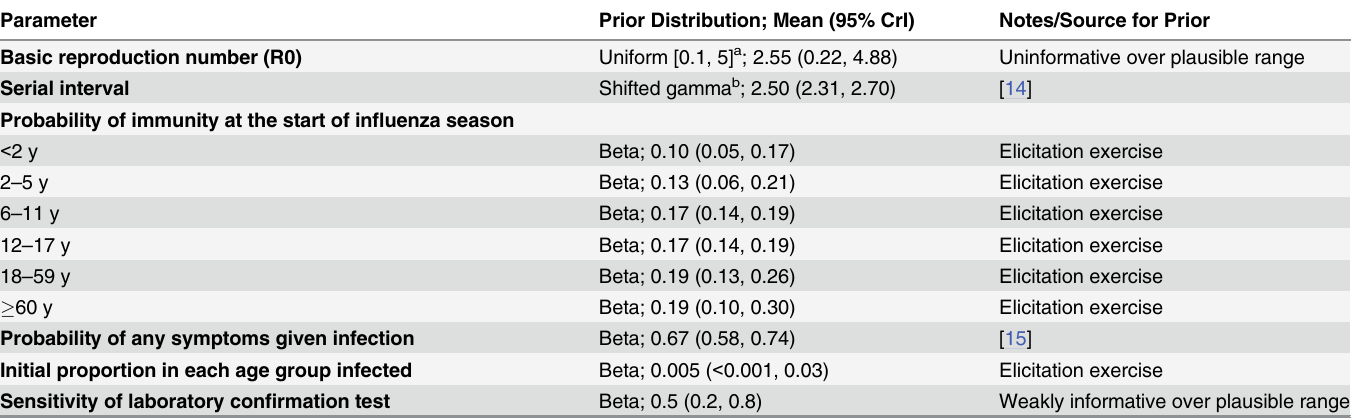
Table 3. Prior distributions for epidemiology model used in the base case